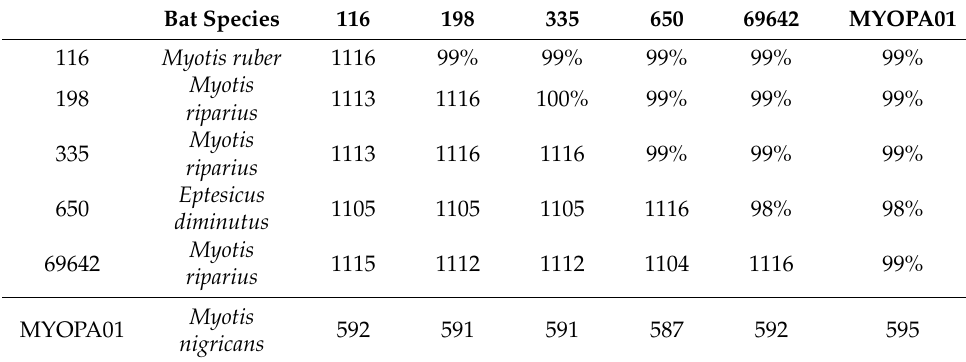
MYOPA01 A G MYOPA01 has 595 bp and thus, there was no overlap for the nucleotides from 789–1086 with the Brazilian sequences (1116 bp). Gray columns show two nucleic acid substitutions found only in this isolate. The sequence obtained from bat 650 was the most divergent, with 98–99% of identity with the others (with 11 or 12 nucleic acid substitutions) (Table 2). The Panamanian sequence presented two to eight nucleic acid substitutions compared to Brazilian sequences (98–99% of identity) (Table 2). Table 2. Similarity percentage between the mitochondrial cytochrome b gene ( cytb ) sequences of Polychromophilus sp. found in different bats from Brazil and Panama